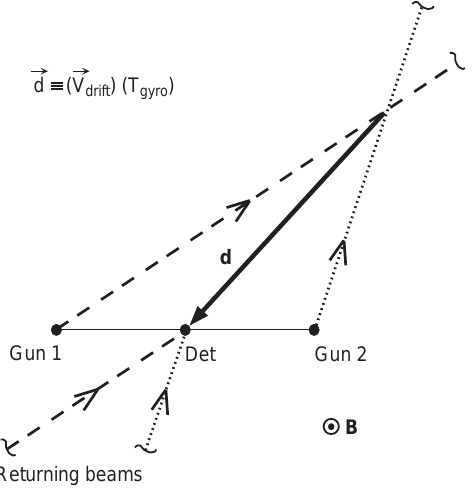
Fig. 1. Triangulation geometry for determining the drift-step vector d . Firingdirections ofthetwoguns( dashed and dotted lines )locatethetail of d when the guns are aimed so that after one gyro orbit the beams return to the detector ( Det ). The gyro radius is large compared to the figure, so the beam trajectories appear as straight lines on